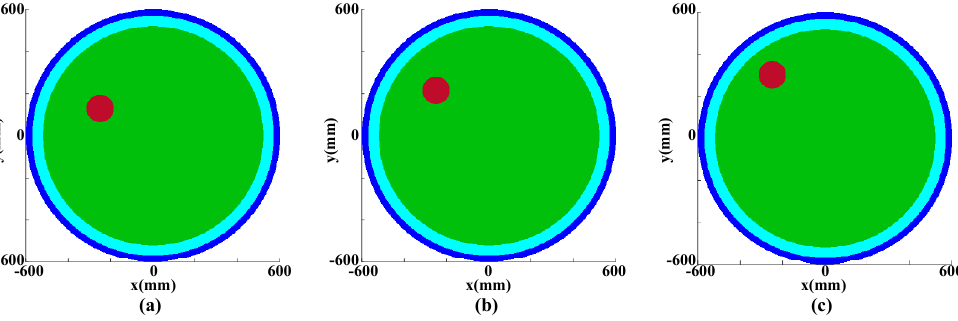
Figure 6. The simulation models of cavities; ( a ) The distances between the cavity center and the interface was 350 mm; ( b ) The distances between the cavity center and the interface was 250 mm; ( c ) The distances between the cavity center and the interface was 150 mm.